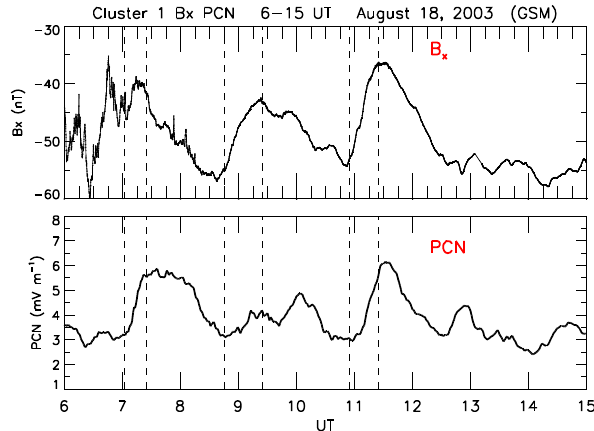
Figure 7. Cluster-1 magnetic field B x component trace (top, from Fig. 5) and the PCN index for the interval 06:00–15:00UT. Three lobe magnetic field perturbation events are delimited by vertical